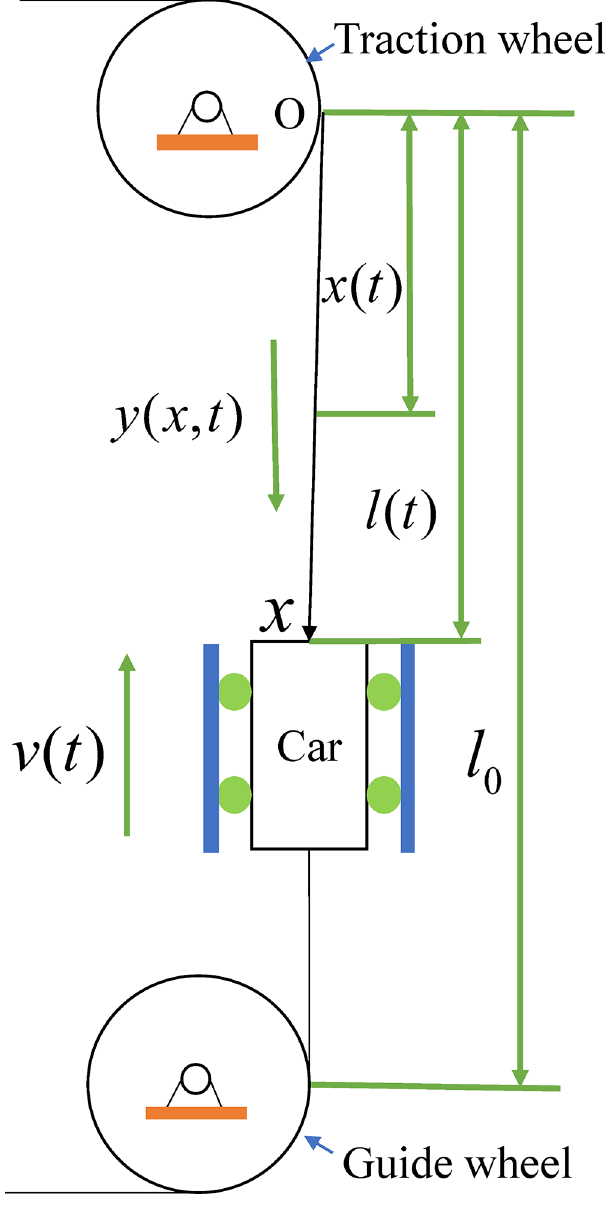
Fig. 1. Time-varying model of the hoisting rope in an elevator lifting